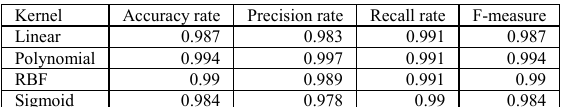
Table 7: Evaluation of each kernel function after noise